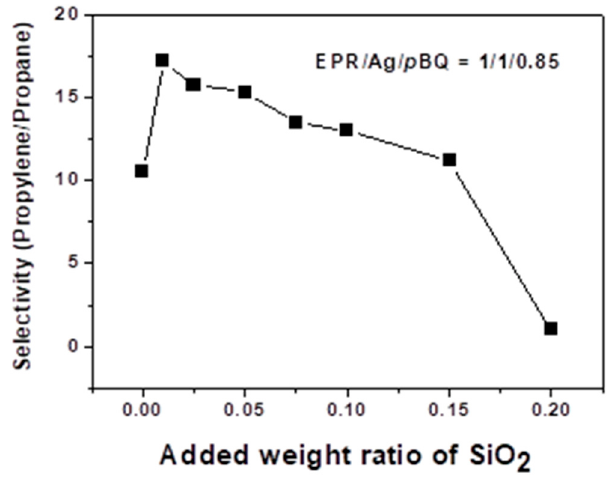
Figure 2. Separation performance: mixed gas selectivity of EPR/Ag metal/ p- BQ membranes with various weight ratios of fumed silica nanoparticles.